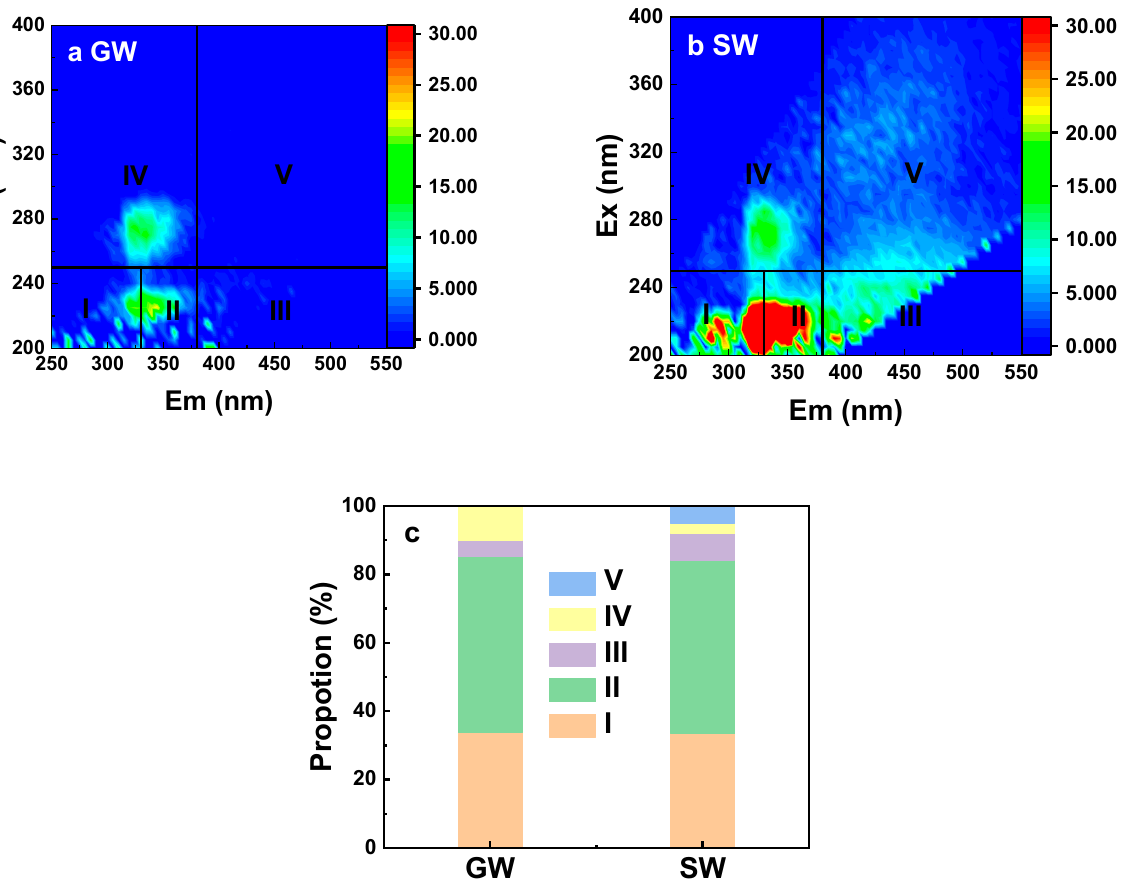
Figure 2. The 3D-EEM spectra of the GW ( a ) and SW ( b ); the fluorescence regional integration (FRI) of GW and SW ( c ).